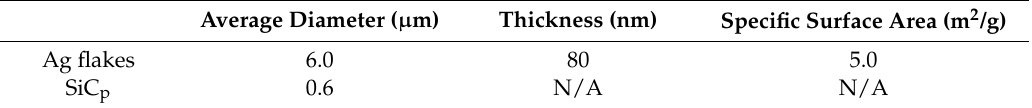
Table 1. Properties of Ag particle and SiC p